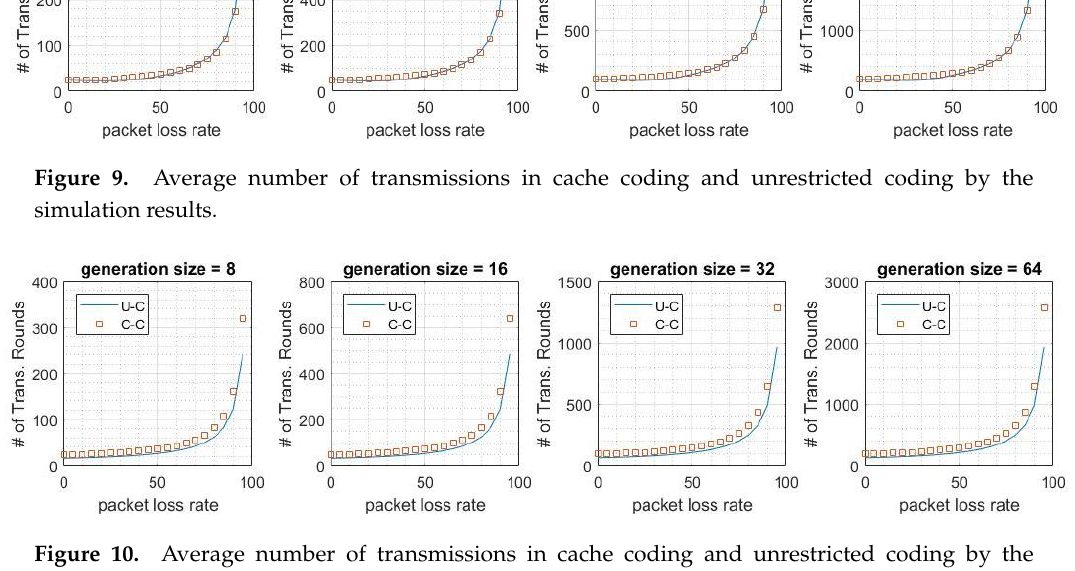
Figure 10. Average number of transmissions in cache coding and unrestricted coding by the heuristic